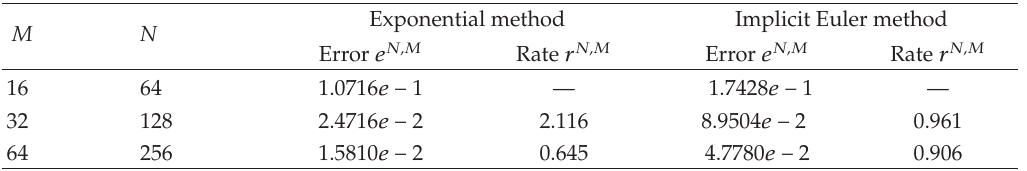
Table 2: Numerical results for Test